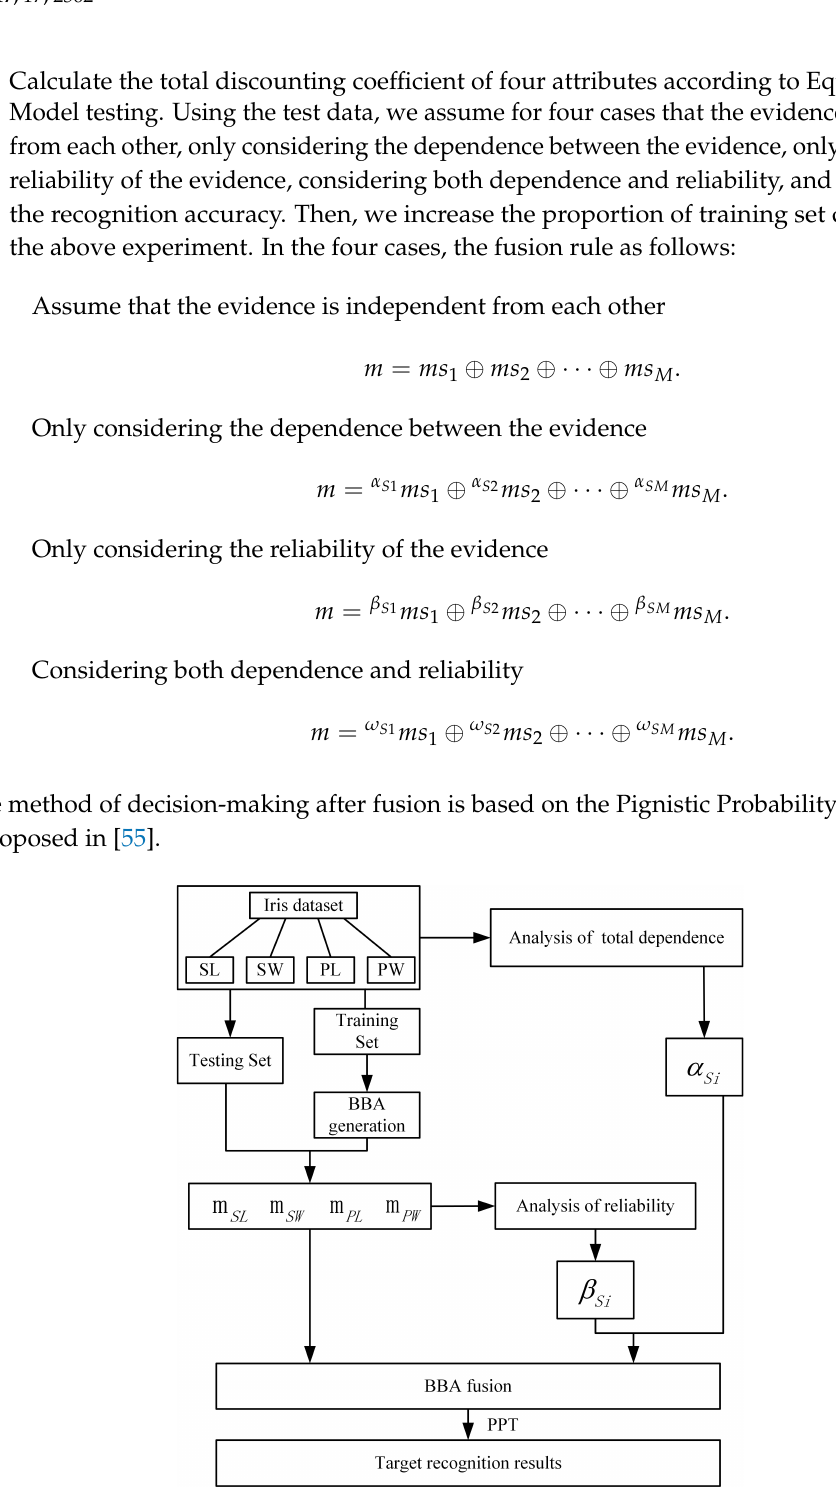
Figure 3. The main procedure of the proposed method to recognize iris